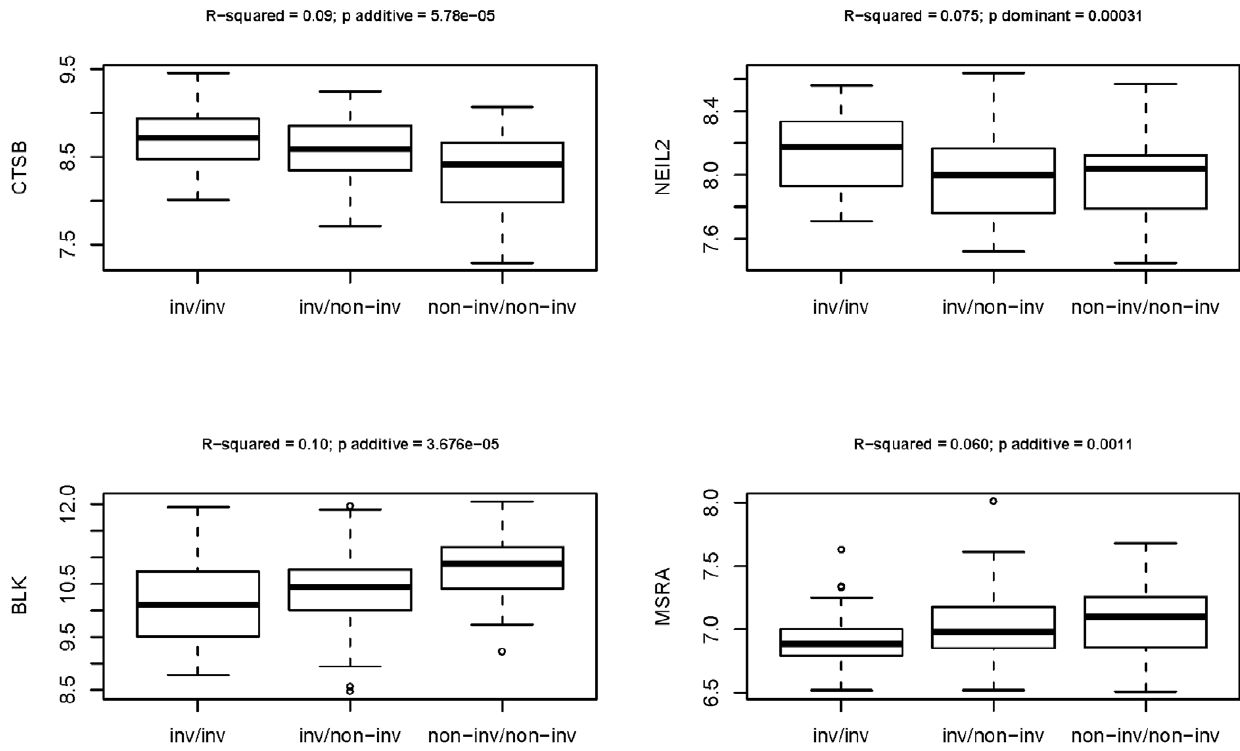
Figure 3. Box-plot representation for the differentially expressed CTSB, NEIL2, BLK and MSRA genes, according to the predicted inversion genotypes. The underlying distributions of expression levels for each of the three possible inversion genotypes: homozygous inverted (inv/inv), heterozygous inverted (inv/non-inv) and homozygous non-inverted (non-inv/non-inv) are shown. On the top of each panel R-squared values derived from general linear model regressions and p-values under the most significant model of inheritance are